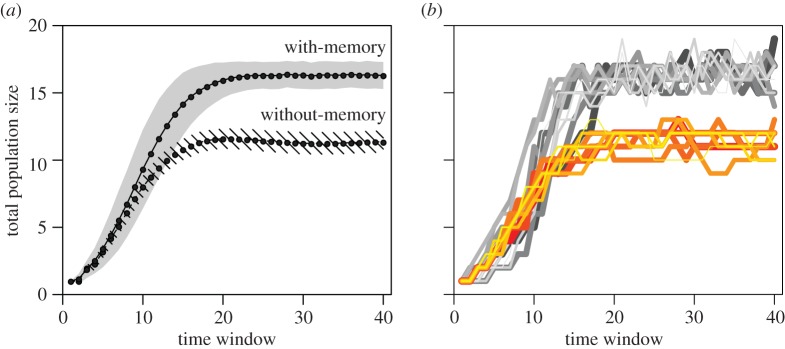
Total population size as a function of the time elapsed since the population's founding (n = 1), measured at the beginning of each time window lasting 5 000 time steps each. (a) Mean ± s.d. (over 1 000 simulations for each population type), for populations of with- and without-memory individuals (plain and dashed lines, respectively). (b) Examples of individual population growth curves. Ten examples are shown for each population type (grey: with-memory; orange: without-memory). Different populations are represented with different line widths for ease of visualization.